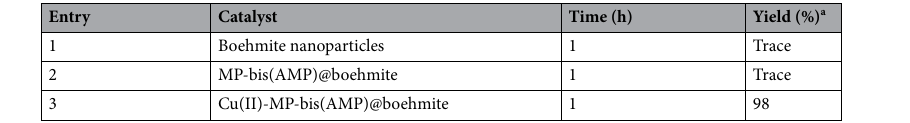
Table 5. A comparison of Cu(II)-MP-bis(AMP)@boehmite with boehmite or MP-bis(AMP)@boehmite as catalyst in the coupling of phenol with iodobenzene under optimized conditions. a Isolated yield. Catalyst (30 mg) and KOH (5 mmol) in DMSO at 130